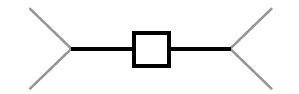
Figure 2.25: The Process Description glyph for process